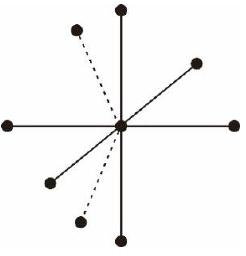
Figure 6. A spin located in a lattice point of a “big” spin lattice has the eight nearest neighbors, six from the original 3D Ising lattice (solid lines) and two from the “imagine” s pin chains (dashed lines).